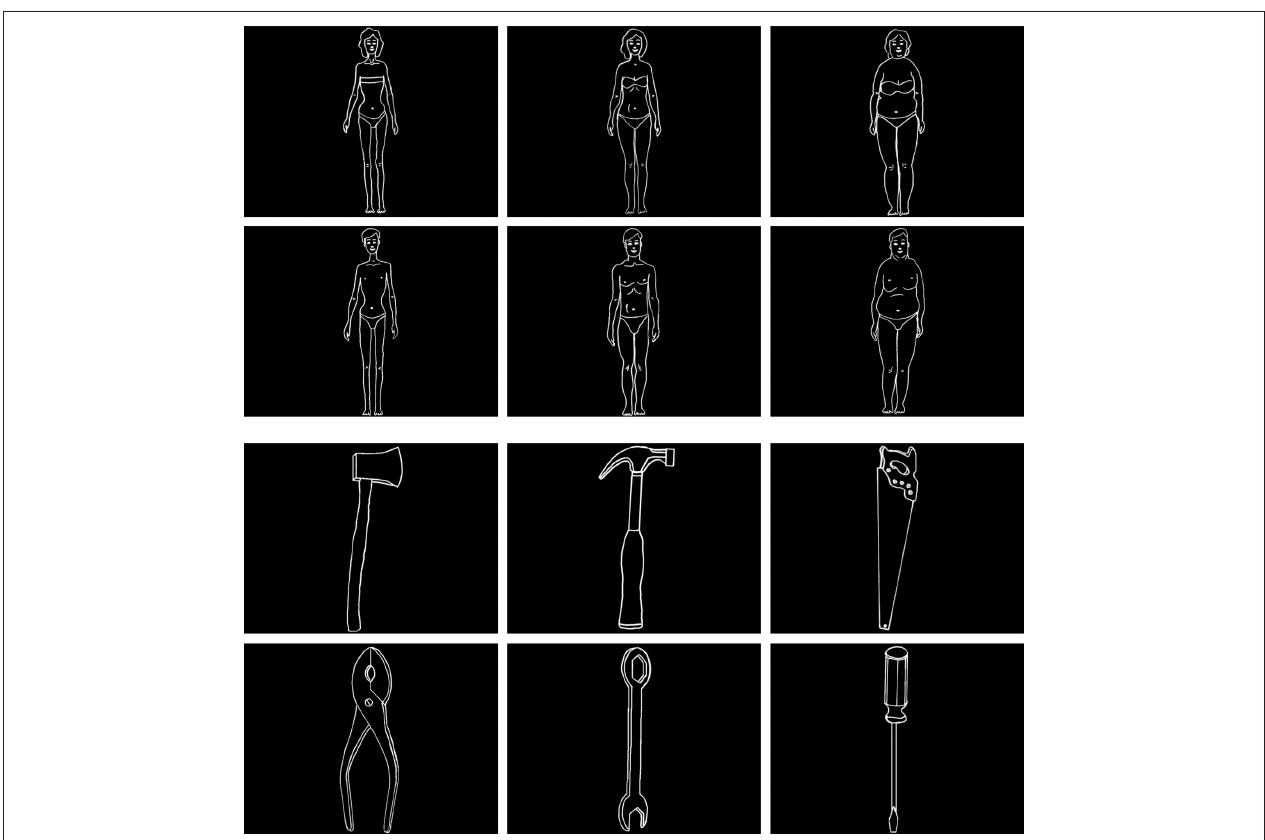
FiguRE 1 | illustration of the body and tool